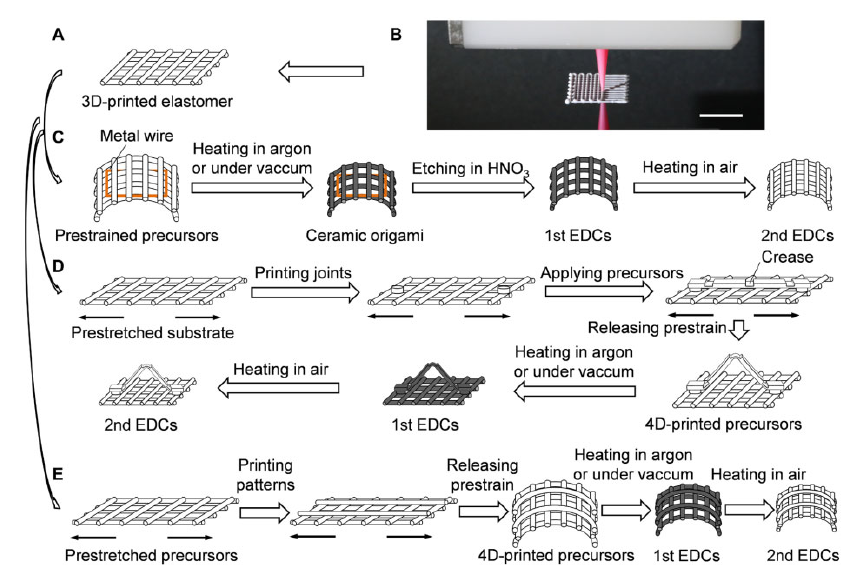
Fig. 47 4D printing of ceramic: (A) 3D-printed elastomeric lattices; (B) DIW of inks; (C) ceramic structures derived from 3D-printed elastomers; (D, E) two 4D printing methods, including method 1 (D) and method 2 (E), together with heat treatment, convert 3D-printed elastomer into 4D-printed ceramics. Reproduced with permission from Ref. [133], © The Authors 2018.